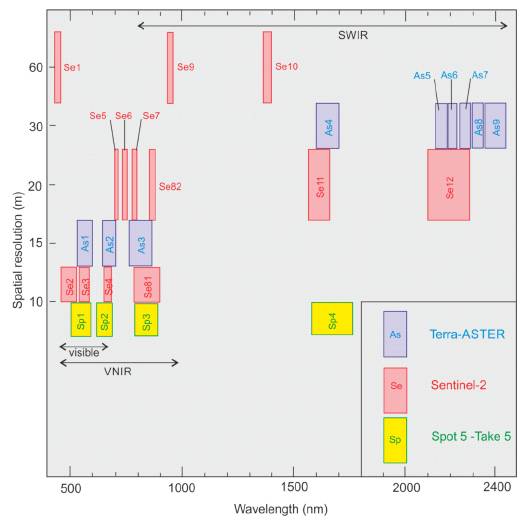
Figure 6. Main characteristics of Terra-ASTER, SPOT and Sentinel-2, and the spectral resolution and the band settings of their multispectral instruments (modified after Fletcher,